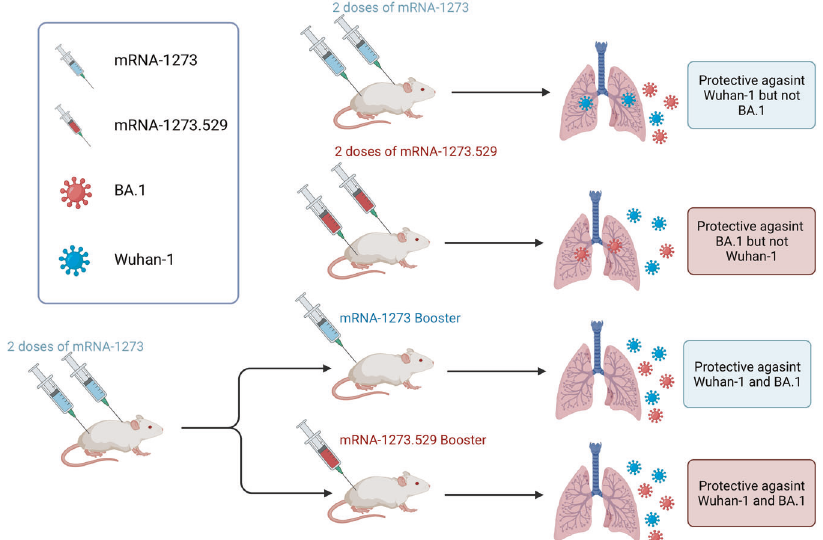
Fig. 1 The protective activities of mRNA-1273 and mRNA-1273.529 as primary (two-dose) immunization series or third-dose boosters were evaluated in mice challenged with Wuhan-1 or